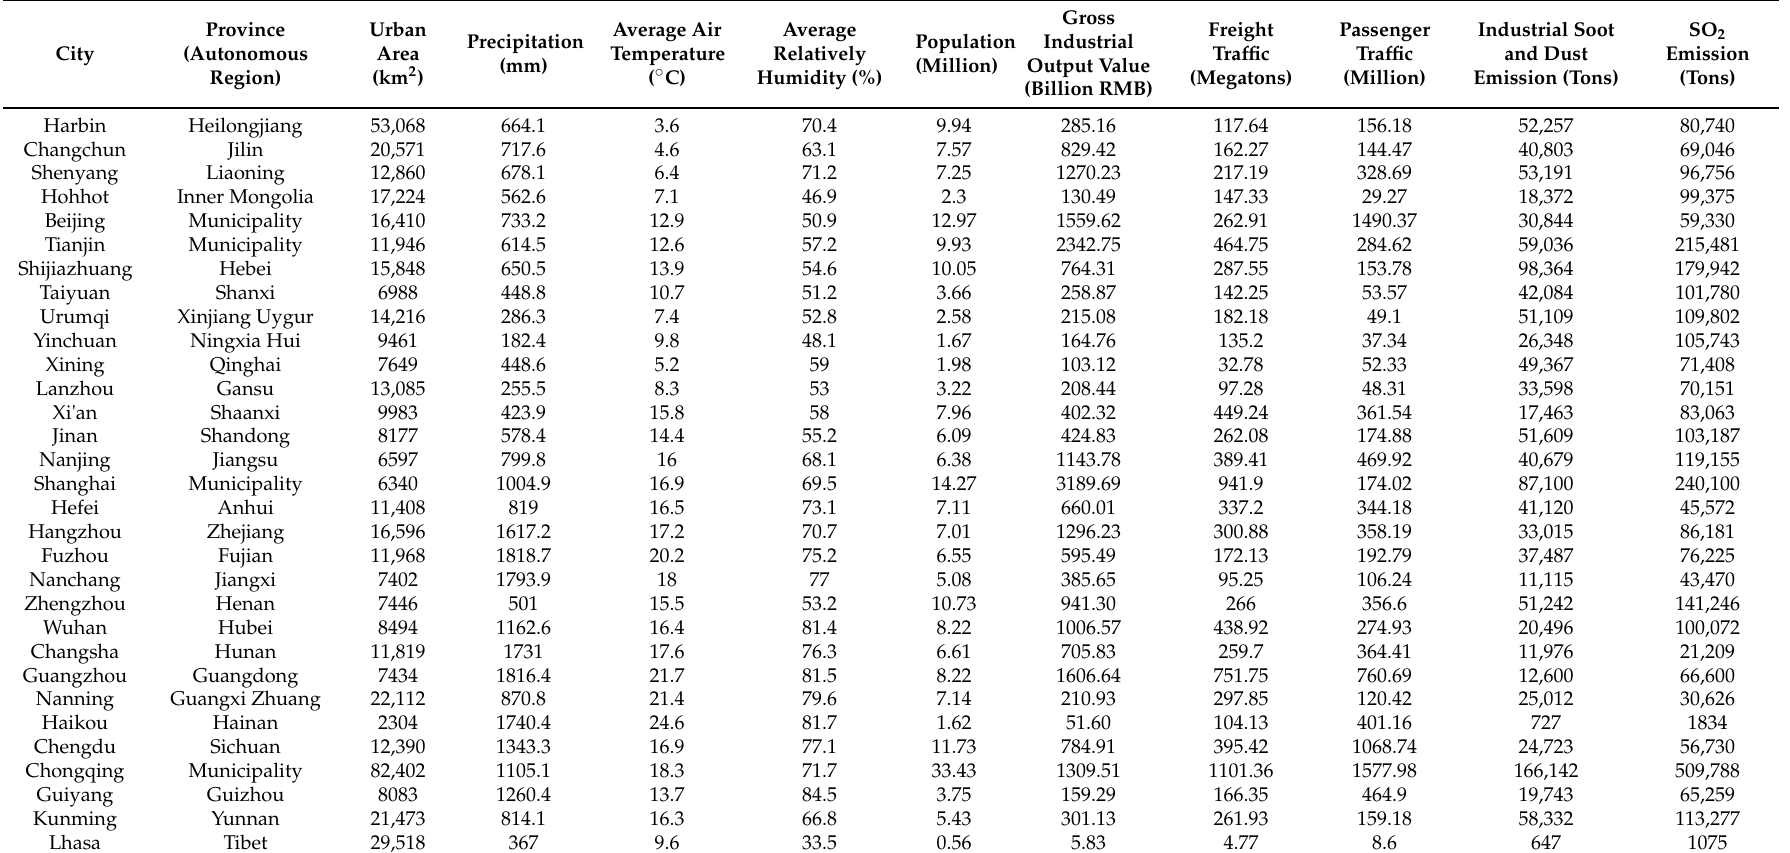
Table A1. Description of the 31 cities examined in this study